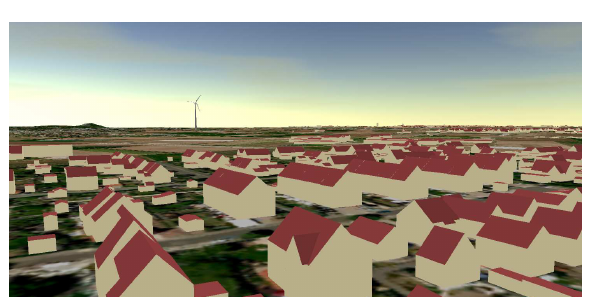
Figure 15. Visualization of a planned wind